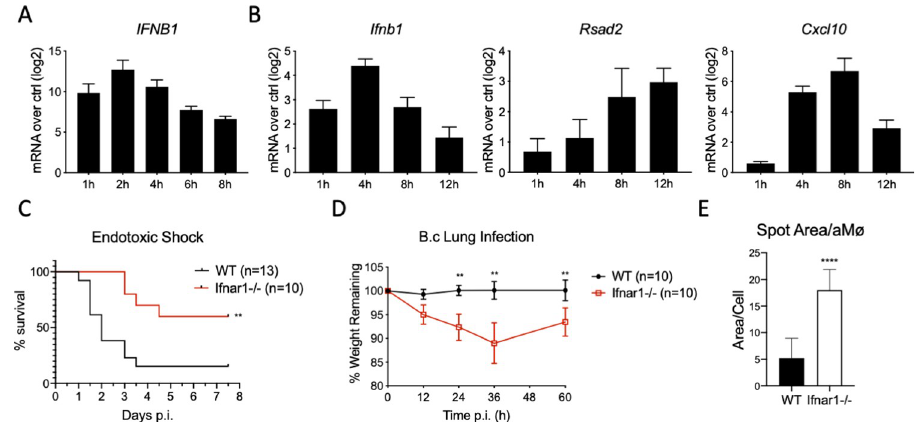
Fig 1. IFN signaling has disparate effects on in vivo LPS stimulation and Gram-negative bacterial infection . A) Differentiated THP-1 cells and B) BMDMs were infected with live Bc for the indicated times before RNA extraction and RT-PCR for given genes. Data show relative mRNA expression to unstimulated cells using Hprt as housekeeping gene; n = 5, representative of two experiments C) Littermate control WT (n = 13) and Ifnar1 -/- (n = 10) mice were injected intraperitoneally with 10 mg/kg of LPS and mice were weighed twice a day for 7 days. D, E) Lightly anesthetized, littermate control WT (n = 10) and Ifnar1 -/- (n = 10) mice were infected with 5x10 6 CFUs of Bc via intranasal instillation. D) Mice were weighed every 12 h for 5 days. E) Broncho-alveolar lavages were performed 16 h post-infection and bacteria were enumerated using high-content imaging; all in vivo experiments are shown as a combination of two independent experiments C) �� = p � 0.01 by Mantel-Cox test; D, E) �� = p � 0.01, ���� = p � 0.0001 by Mann-Whitney U test.